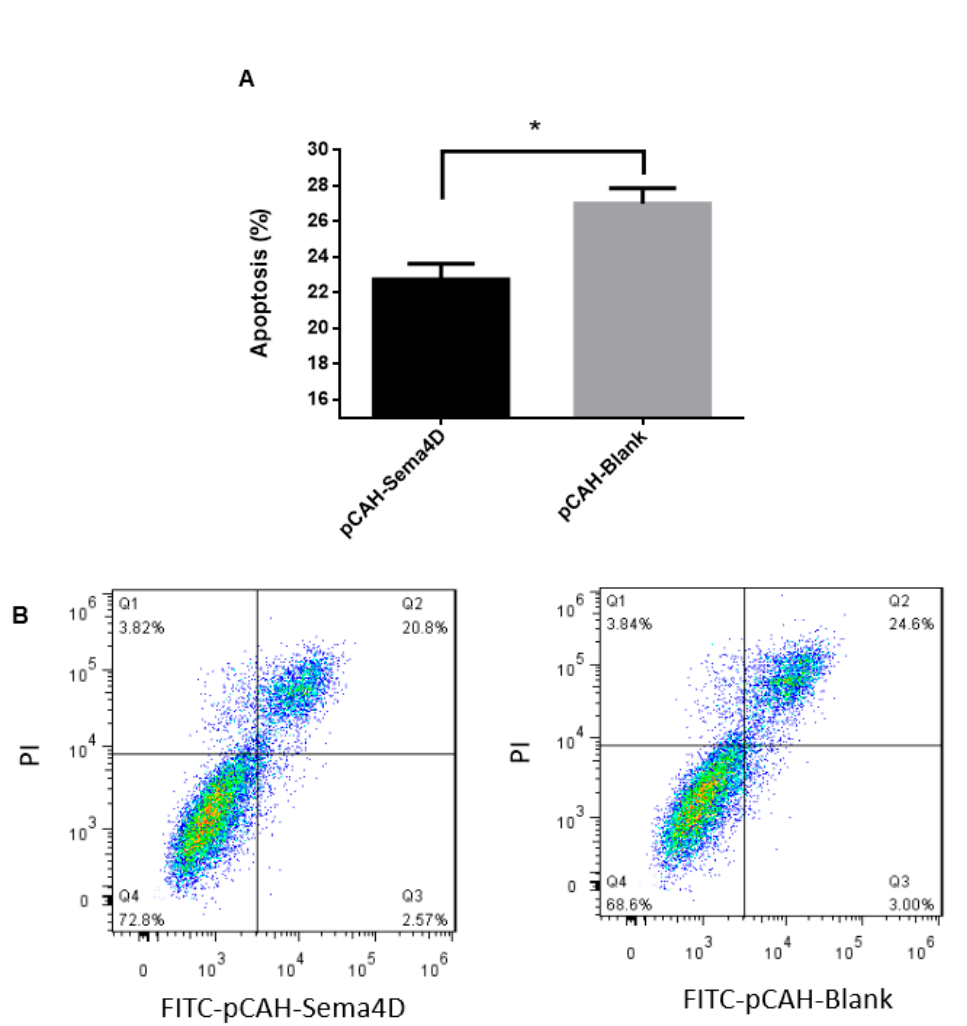
Figure 5. Sema4D suppresses HP45 cell apoptosis. ( A ) pCAH-Sema4D (2 µ g) or pCAH-Blank (blank vector) expression vectors were transfected into HP45 cells in 6-well plates. ( B ) Flow cytometric analysis of the e ff ect of miR-125b on HP45 cell apoptosis. Q1 represents dead cells; Q2 represents late-stage apoptotic cells; Q3 represents the early-stage apoptotic cells; Q4 represents normal cells. Data are provided as means ± standard deviation of triplicate measurements from a representative experiment. * p < 0.05.